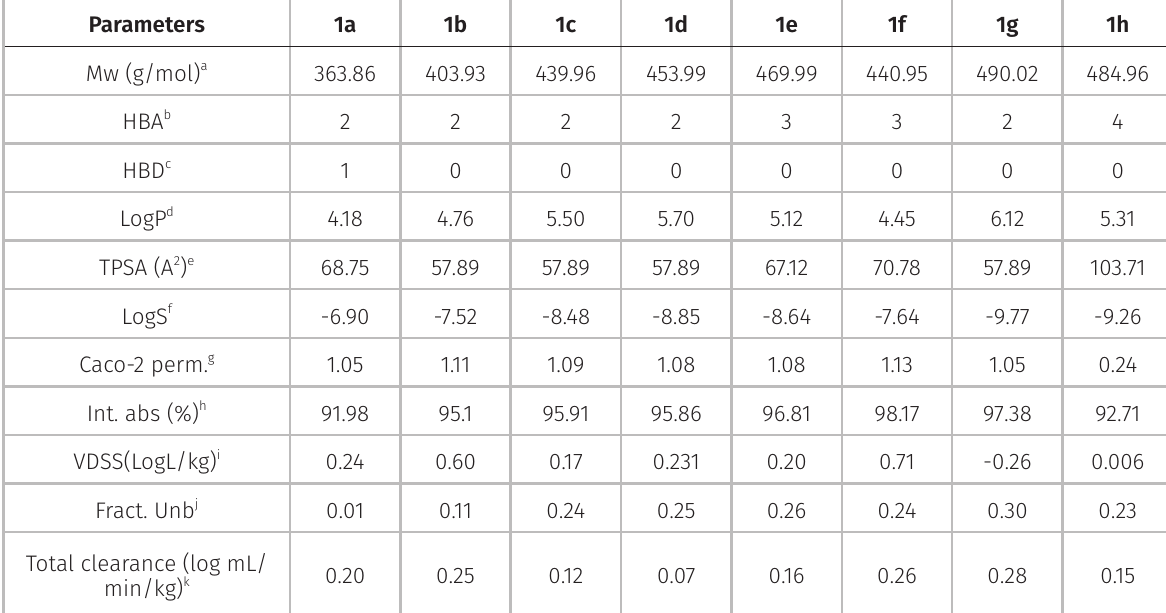
Table I. In silico pharmacokinetic properties: adsorption, distribution, metabolism and excretion for the compounds under